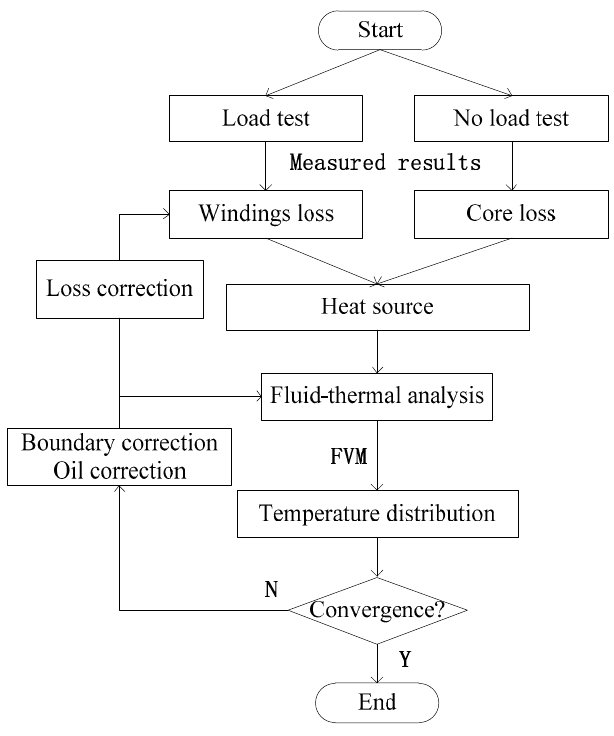
Figure 1. The flowchart of coupled Fluid-Thermal field analysis.